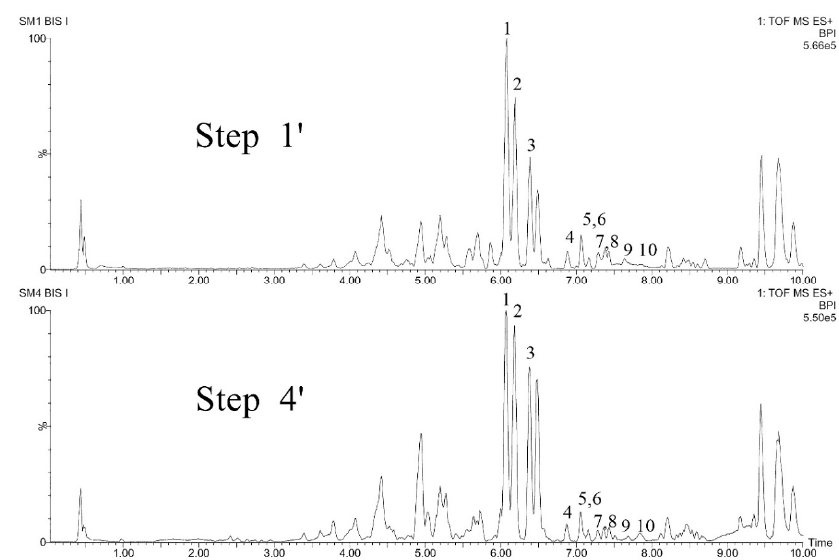
Figure 11. Base peak ion chromatograms comparing steps 1 ′ and 4 ′ of the seedling leaf explants from Swietenia macrophylla. Molecules 2020 , 25 , x FOR PEER REVIEW